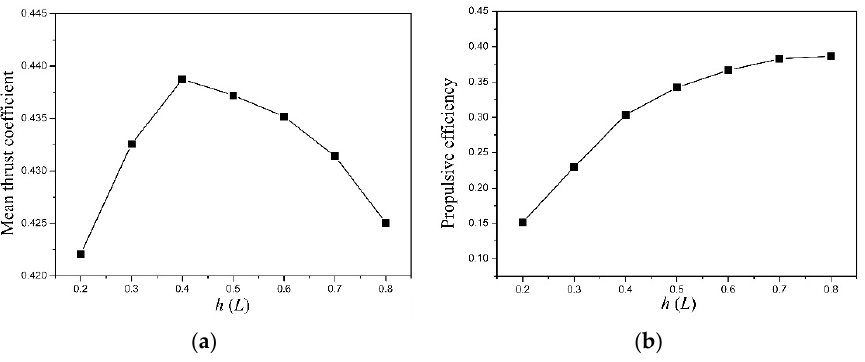
Figure 12. Performance curves versus amplitude of heave motion: ( a ) mean thrust coefficient; ( b ) propulsive efficiency.